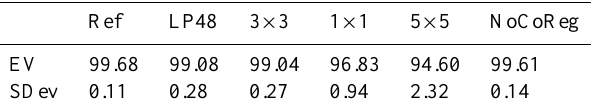
Table 3. Effect of image coregistration and spatial averaging meth- ods on the explained variance (EV) and its standard deviation (SDev) for the linear model of HRV, 0.6 and 0.8µm reflectance ex- pressed by Eq. (5) and given in percent. For a description of the different methods, see the text.